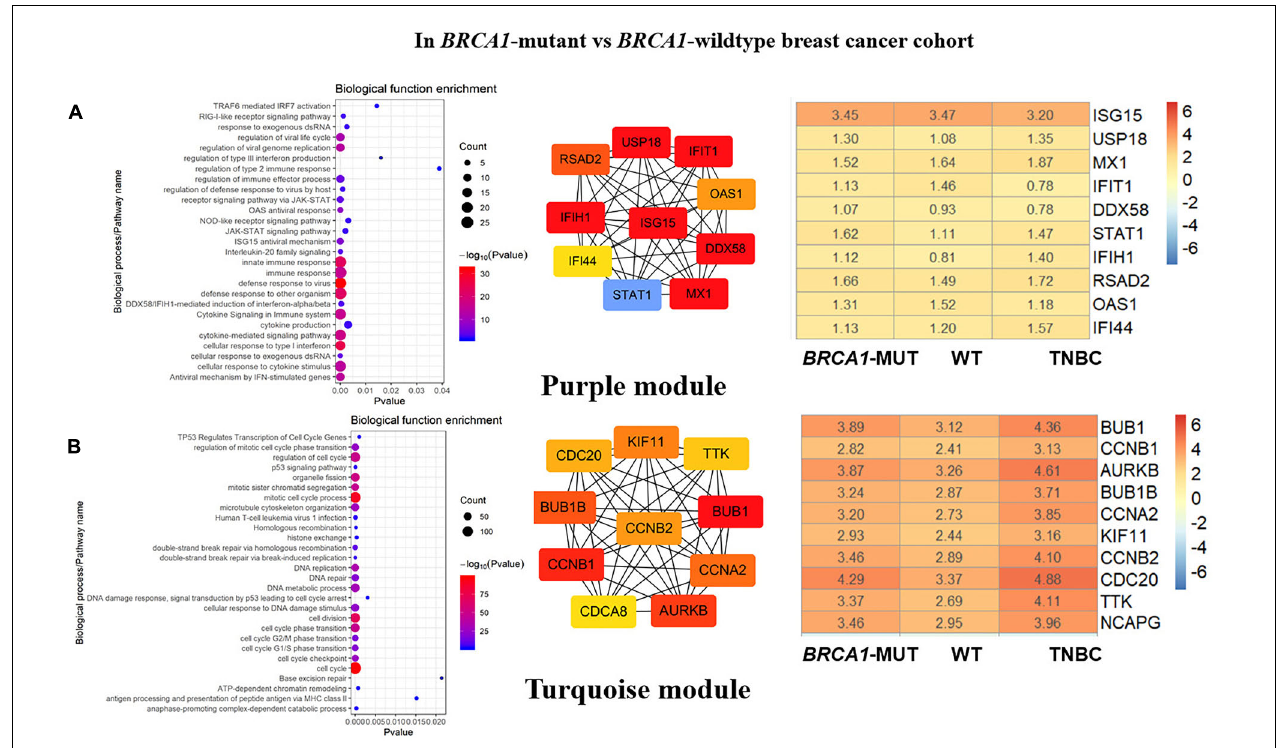
FIGURE 3 | Biological function enrichment results for genes in clinically significant modules in BRCA1 -MUT BC and gene network analysis. Biological function enrichment and corresponding gene information are shown for BRCA1 -associated clinically significant modules. (A) Purple module, (B) Turquoise module. Left column: Top GO terms and KEGG pathways for genes from clinically significant modules. Middle column: Protein–protein interaction networks of top 10 most connected genes with highest degree in modules, constructed using STRING and Cytoscape. Right column: Heatmaps showing log2FC values for top 10 most connected genes. The ordinate is the gene name, and the abscissa ( BRCA1- MUT, WT, and TNBC) represents different BC datasets from TCGA. Red represents log2FC > 0, blue represents log2FC < 0. Values are log2FC values of each gene in three sets, where FC is calculated as the mean gene expression within a group divided by the corresponding gene expression of normal